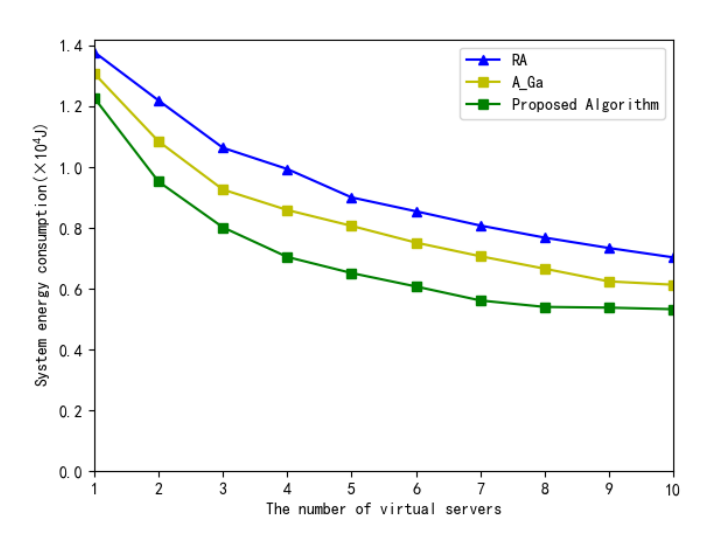
Figure 11. The total system energy consumption versus the number of virtual